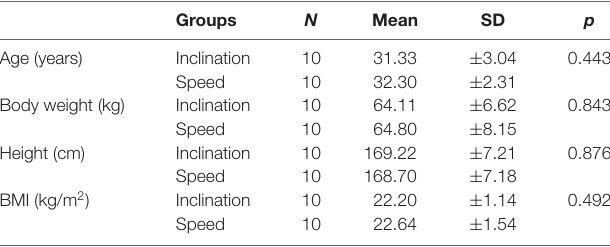
TABLE 1 | Demographic characteristic.